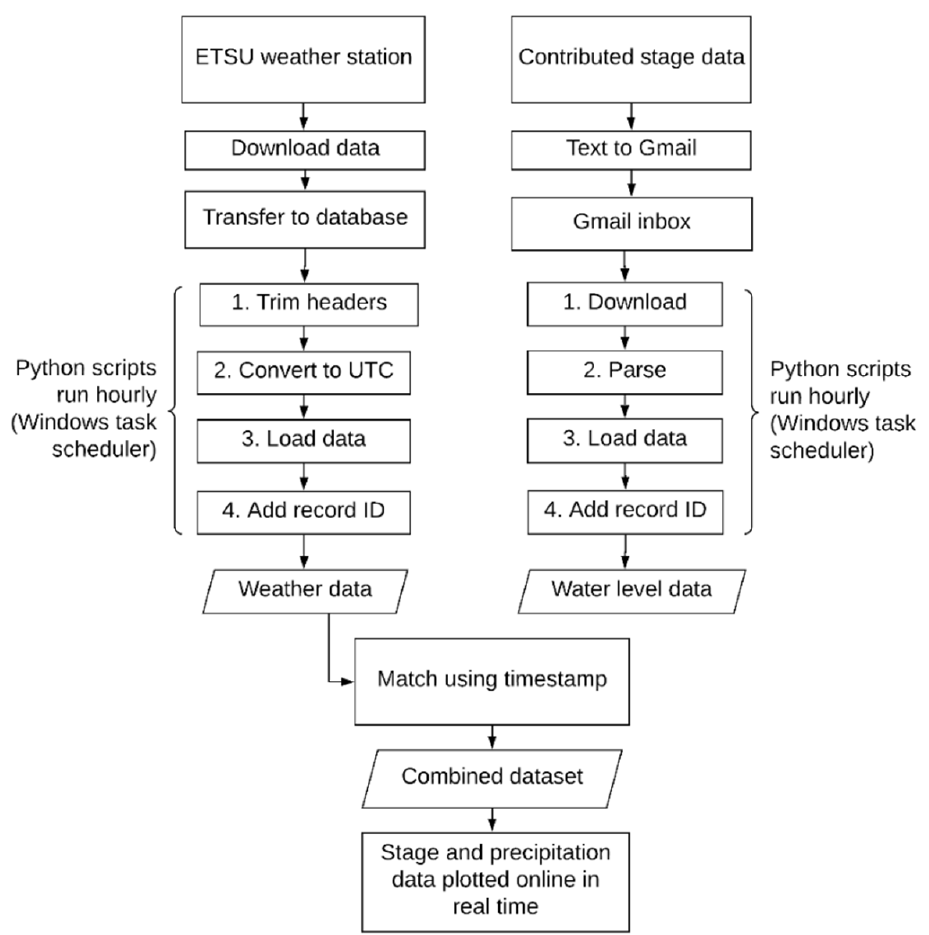
Figure 4. Automated workflow to extract stage data from text messages and load stage and weather data into database.